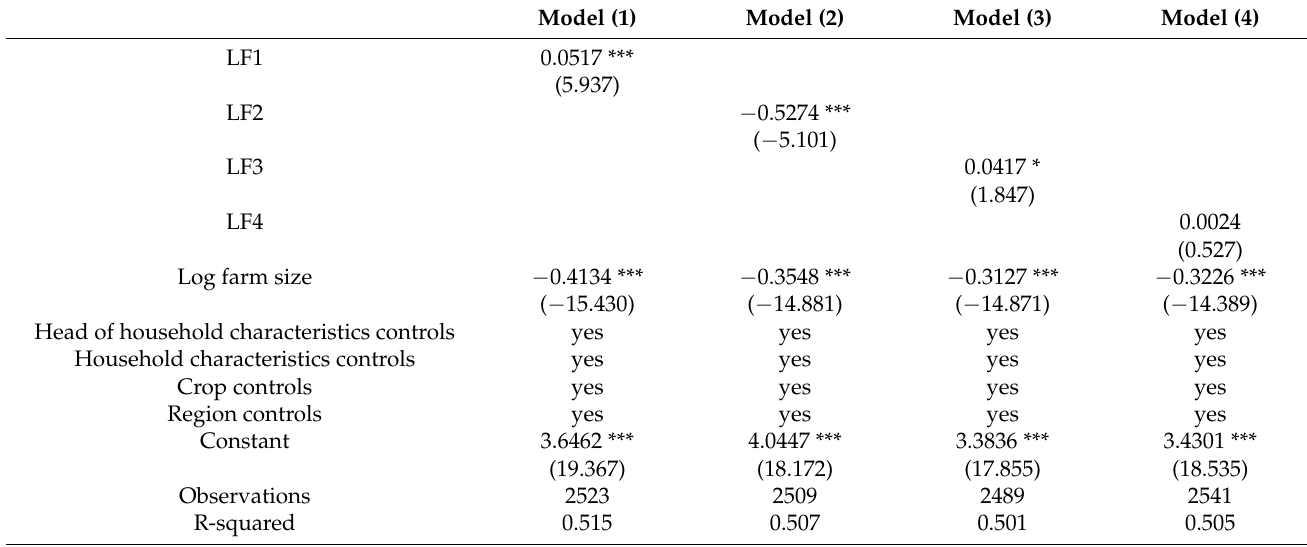
Table 9. Analysis of the effect of LF on labour cost (the labour cost of farmers’ labour was calculated at one-half the prevailing